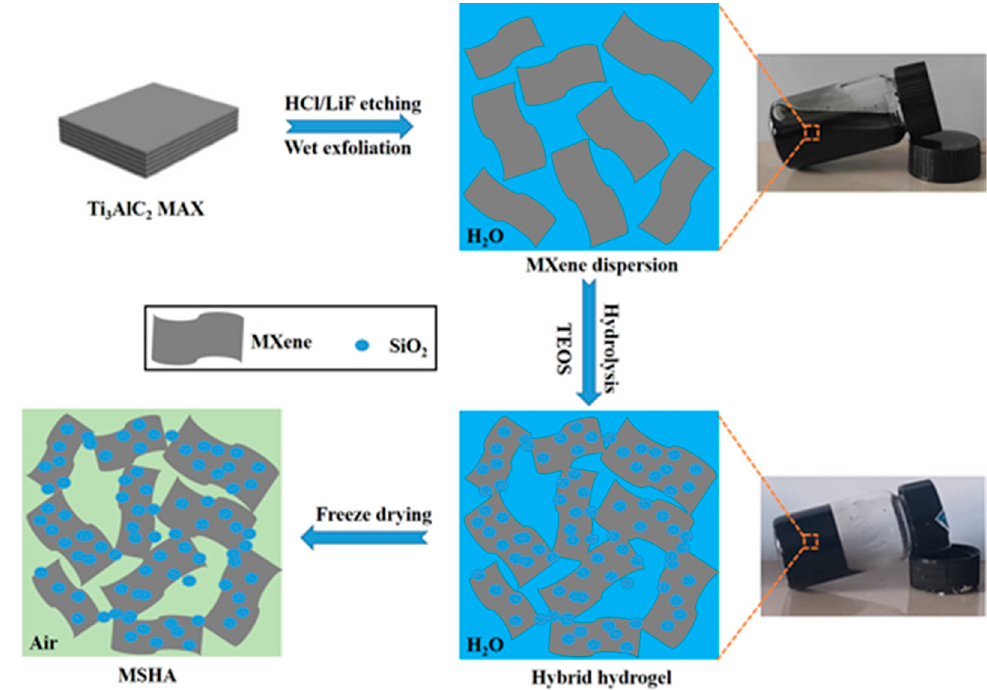
Figure 1. The preparation diagram of